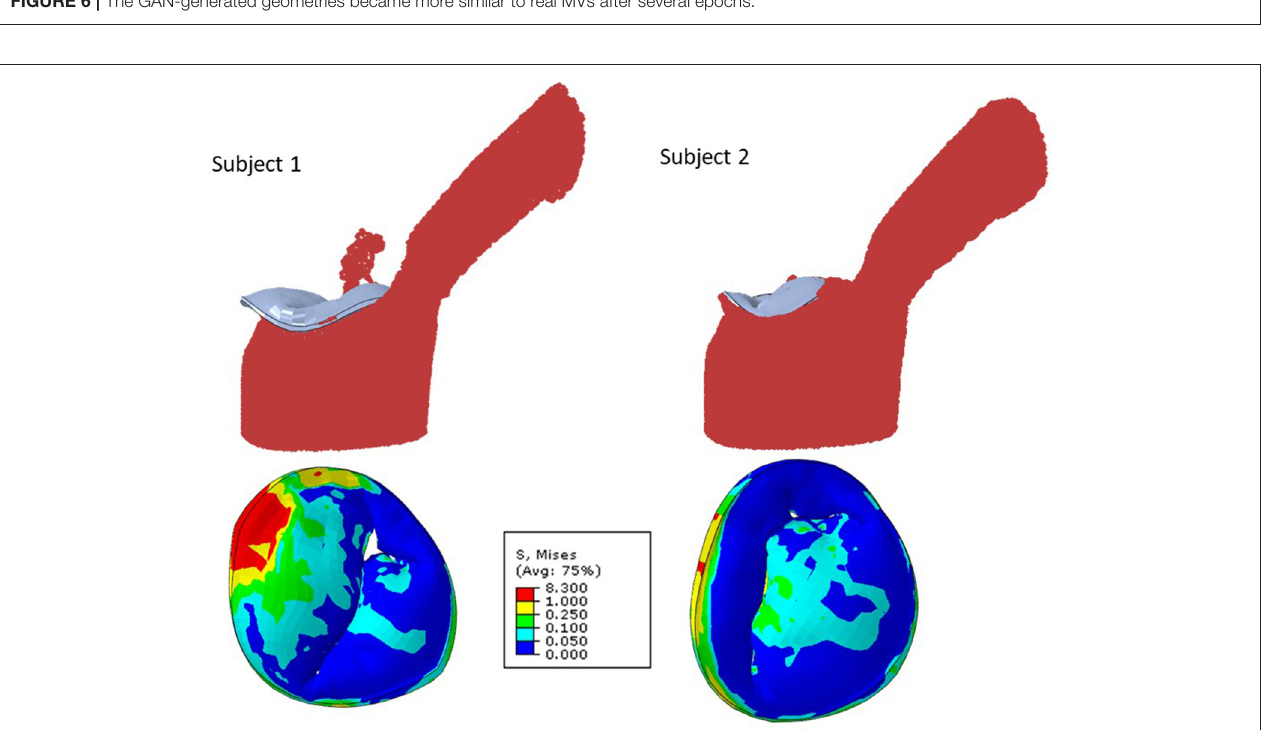
FIGURE 7 | The MR and leaflet stress for two different